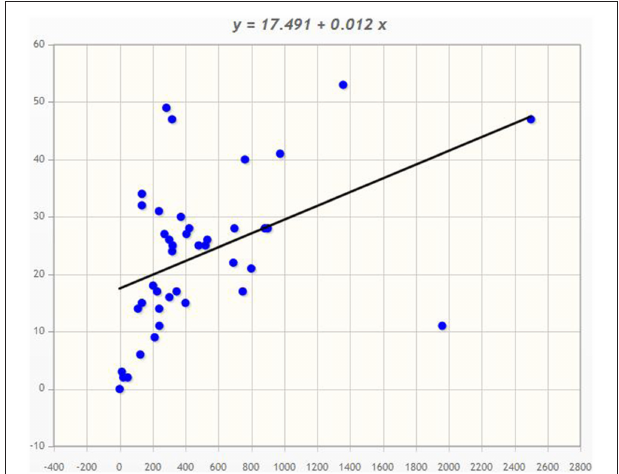
FIGURE 1 | Correlation regression analysis of Genome size and CPK gene family size. The correlation regression analysis shows, the genome size of an organism is not directly proportional to the size of the gene family. The bigger the genome size isn’t directly proportional to the bigger the gene family. In the majority of cases, plant encodes 10–30 CPKs per genome. The X-axis denotes the genome size and Y-axis denotes the CPK gene family size.